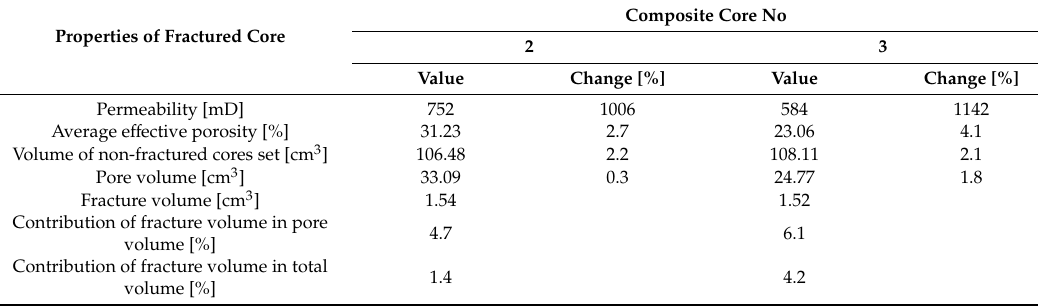
Table 5. Properties of composite cores with the artificial fracture.